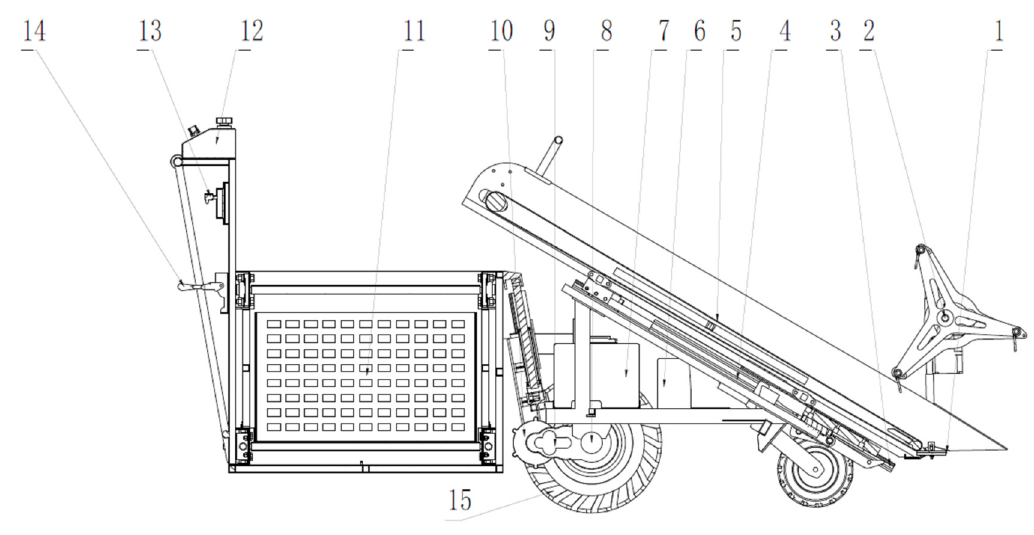
Figure 3. Sketch of the structure of the 4UM-120D electric leafy vegetable harvester. 1. Reciprocating double-acting cu tt er 2. Reeling mechanism 3. Slide rail 4. Electric push rod 5. Conveyor mechanism 6. Control box 7. Forty-eight-volt lithium battery 8. Differential 9. Reducer 10. Traveling drive motor 6. Control box 7. Forty-eight-volt lithium ba tt ery 8. Di ff erential 9. Reducer 10. Traveling drive motor 11. Collection basket 12. Control panel 13. Gear shift knob 14. Brake knob 15. 11. Collection basket 12. Control panel 13. Gear shift knob 14. Brake knob 15. Wheel.